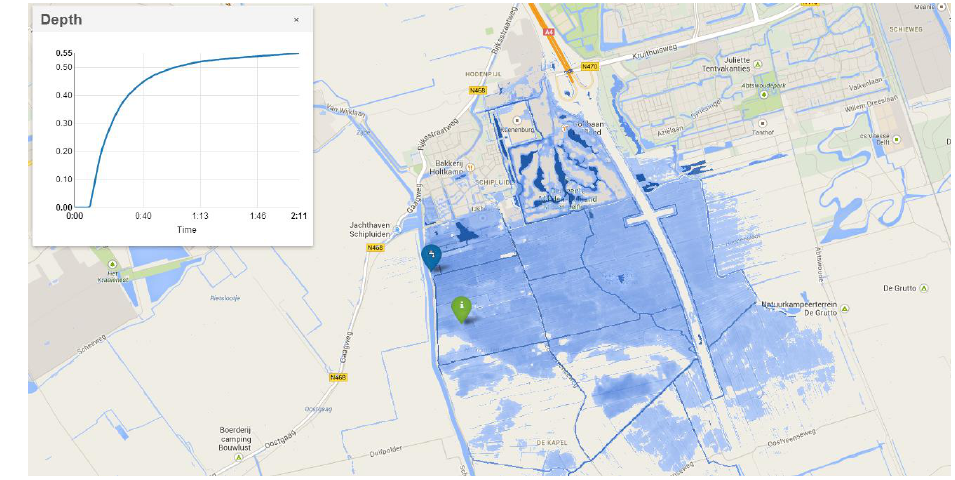
Figure 4. Display of interactive model 3Di [20].